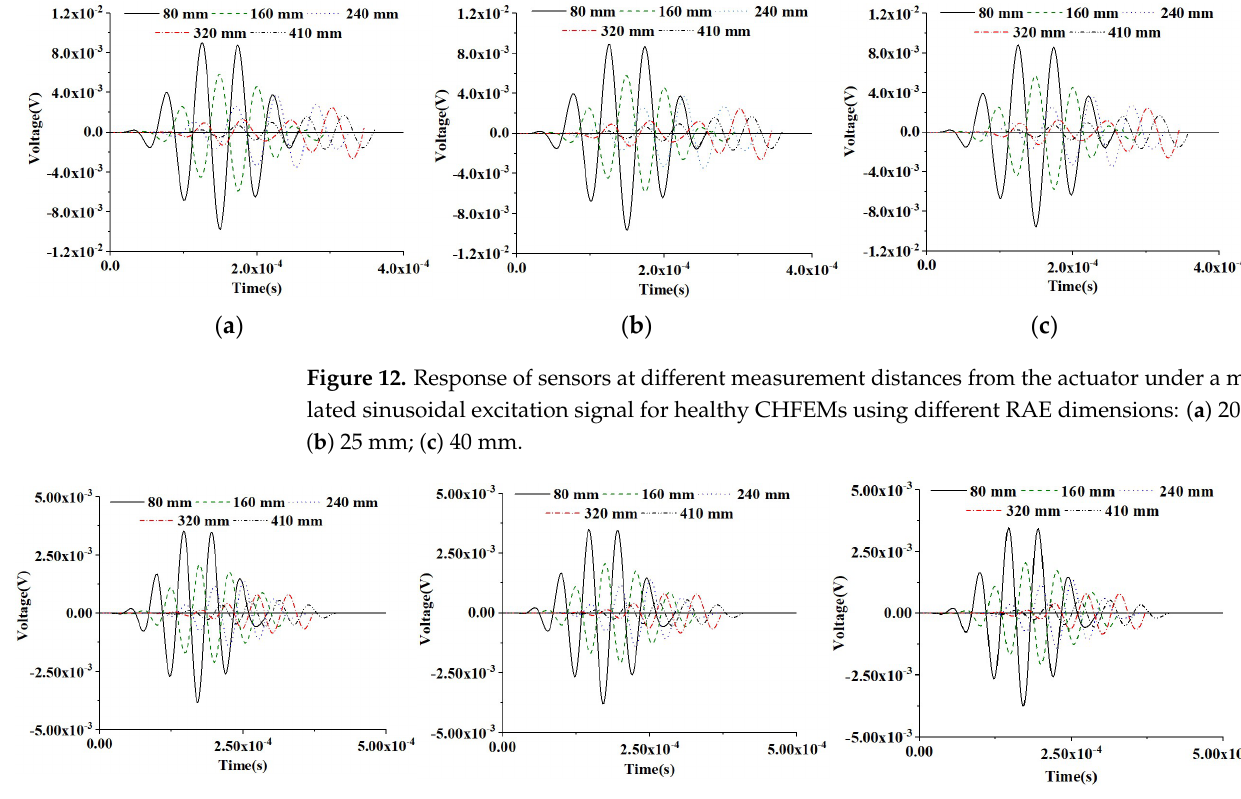
( c ) Figure 11. Response of PZT sensors at different measurement distances from the actuator under modulated sinusoidal excitation of CHFEMs with an interface debond corresponding to CMFEM 1 using different RAE dimensions: ( a ) 20 mm; ( b ) 25 mm; ( c ) 40 mm. 5.2.2. PZT Sensor Measurement under a Modulated CHFEM Sinusoidal Input Signal A further investigation on the influence of RAE dimensions of CHFEMs on PZT sen- sor responses under the modulated sinusoidal excitation signal is performed. Figure 12 displays the time-domain response of PZT sensors at different measurement distances of the healthy CHFEMs with different RAE dimensions. The consistency of PZT sensor re- sponses to different CHFEMs at identical measurement distances and the a(cid:308)enuation and